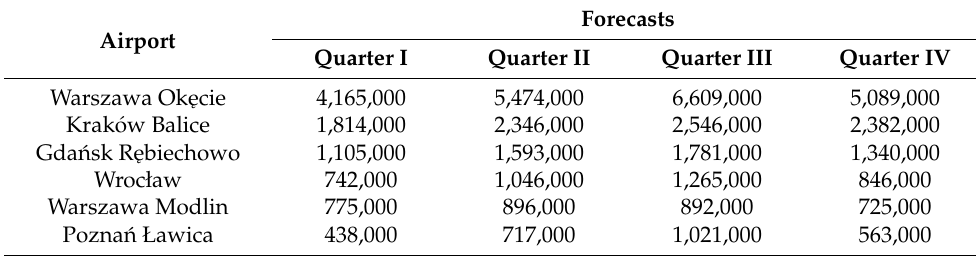
Table 6. Forecasts for individual quarters of the year 2020—the one-name period trend